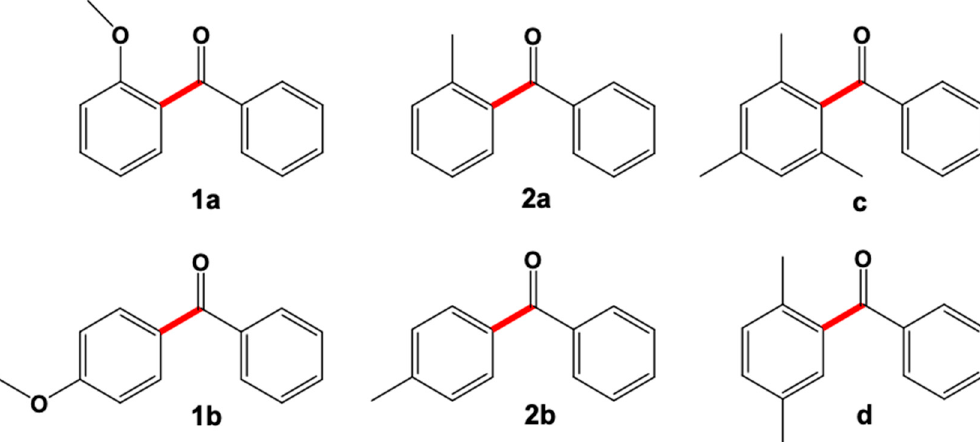
Figure 7. Reactivity of Huntly-GP catalyst in the acylation of several arenes with BzCl. Reaction conditions; 13 mL aromatic, 1 mL BzCl, 0.1 g catalyst; T = 130 °C for all aromatics except toluene 110 °C.